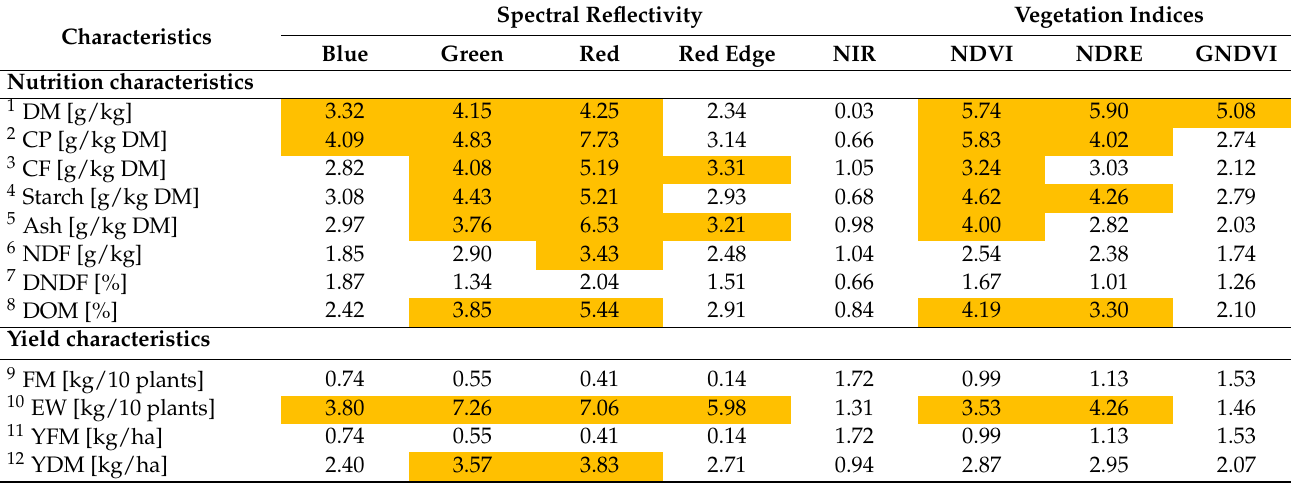
Table 6. The linear correlation rates. Correlation Very weak Weak Medium Strong Very strong In the individual correlation coefficients, we calculated the statistical significance val- ues, and these were subsequently compared with the critical value of 3.143. The statistically significant values are highlighted in Table 7. Table 7. The statistical significance of the correlation data acquired through multispectral imaging and by means of the chemical analyses. Spectral Reflectivity Vegetation Characteristics